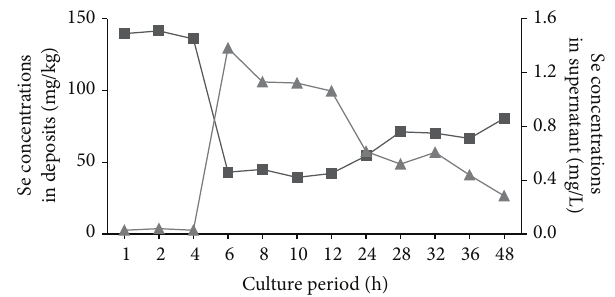
Figure 5: Se concentrations in the supernatant and deposit. ◼ : Se concentrations in supernatant (mg L −1 ); 󳵳 : Se concentrations in deposit (mg kg −1 ).